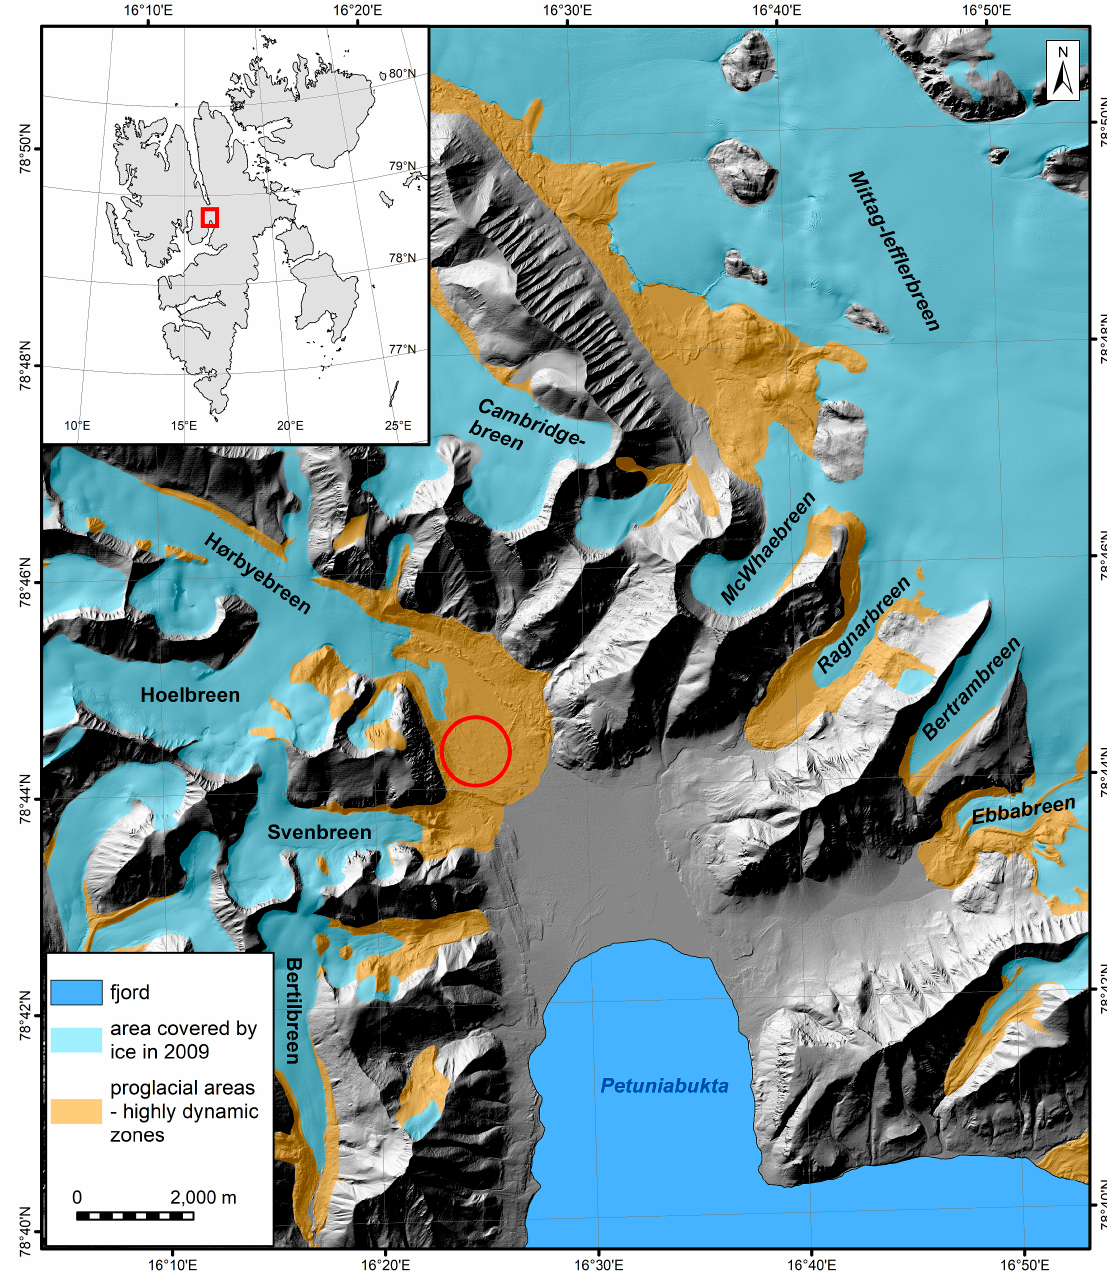
Figure 3. Location of the study area; red circle indicates the approximate location of the surveyed part of the Hørbyebreen foreland. Reprinted from Geomorphology, 325: 40–54, Ewertowski et al., “Quantification of historical landscape change”, Copyright (2019), with permission from Elsevier [4].